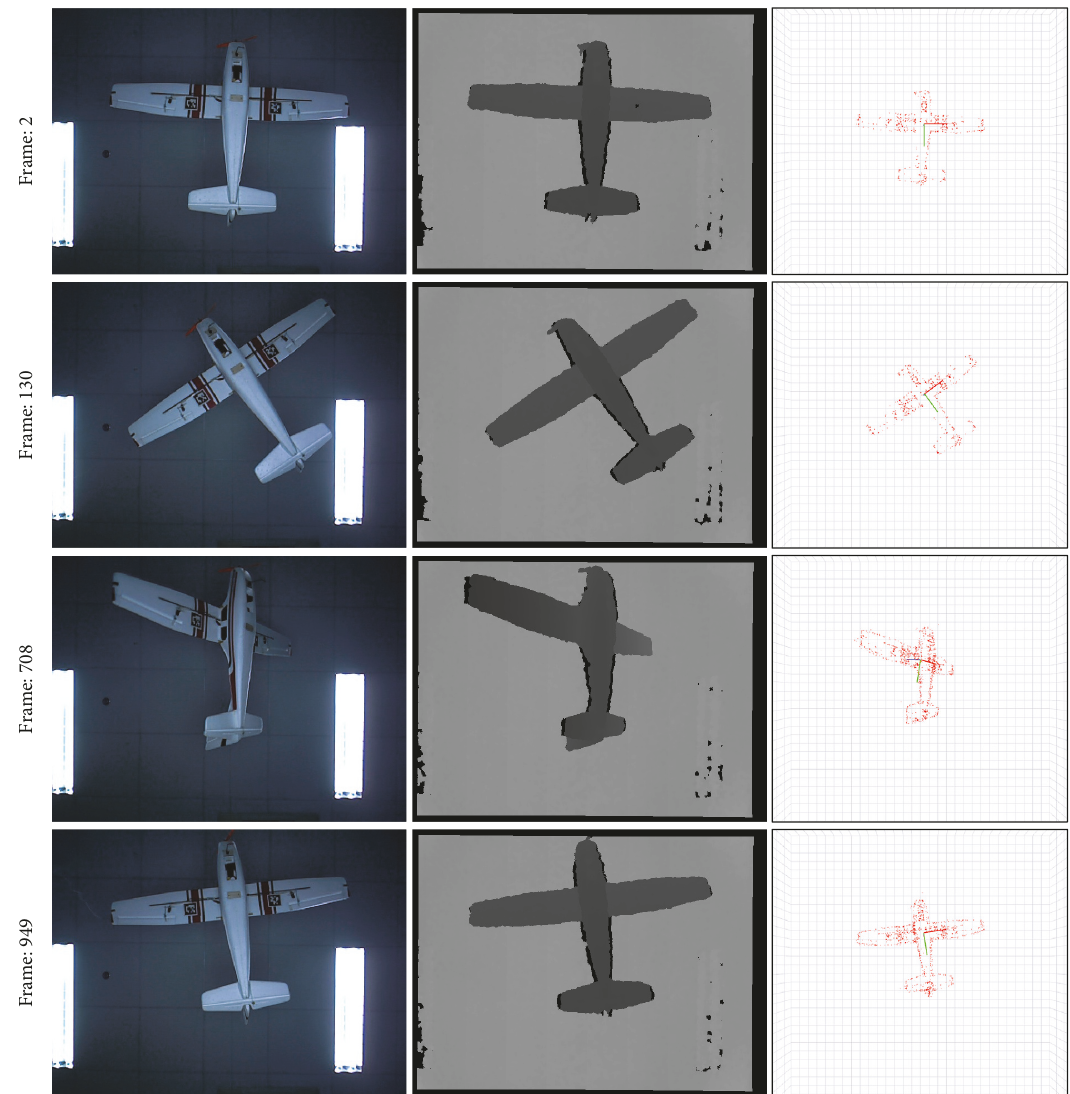
Figure 12: The real scene RGB-D input and the estimated point cloud result of our